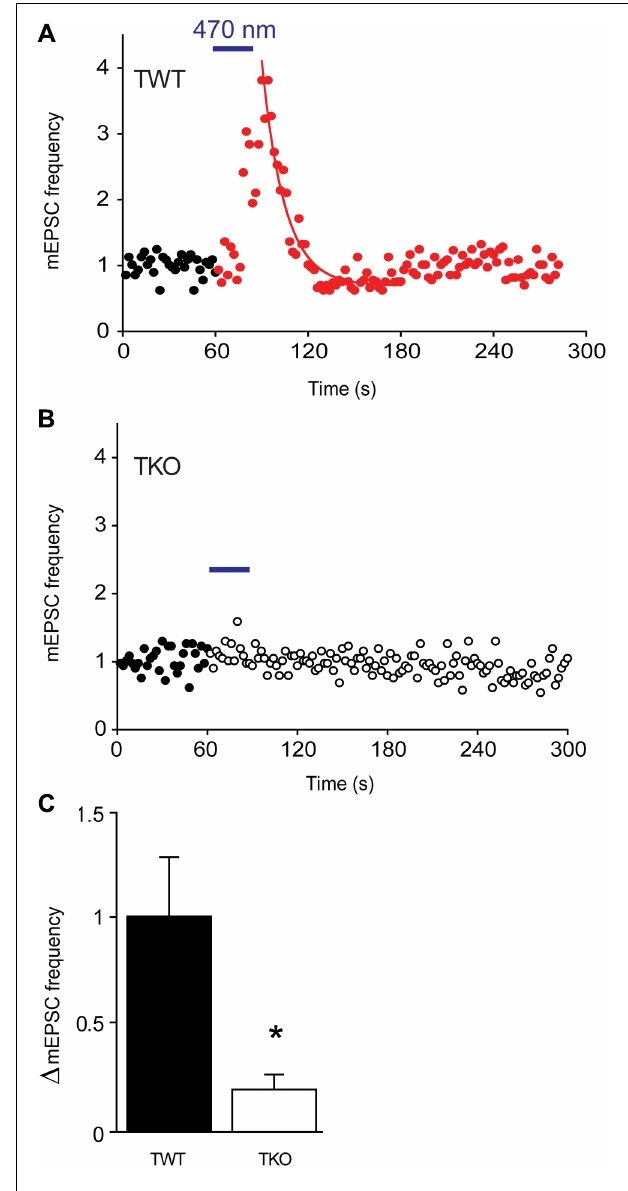
FIGURE 7 | Changes in mEPSC frequency produced by optogenetic elevation of presynaptic cAMP levels. (A) Time course of normalized mEPSC frequency in response to illumination (470 nm light, 30 s at blue bar) of a TWT neuron expressing opto- β 2-AR. Red points indicate mEPSC frequency, normalized to baseline values, measured following the start of the light flash. Smooth curve indicates an exponential fit to the decay of mEPSC frequency following the end of the light flash. (B) Same for a TKO neuron expressing opto- β 2-AR. Open symbols indicate normalized mEPSC frequency measured following the start of the light flash. (C) Mean increase in mEPSC frequency produced by activation of opto- β 2-AR in WT (black) and TKO (white) neurons. Error bars indicate ± SEM, while asterisks indicate significant